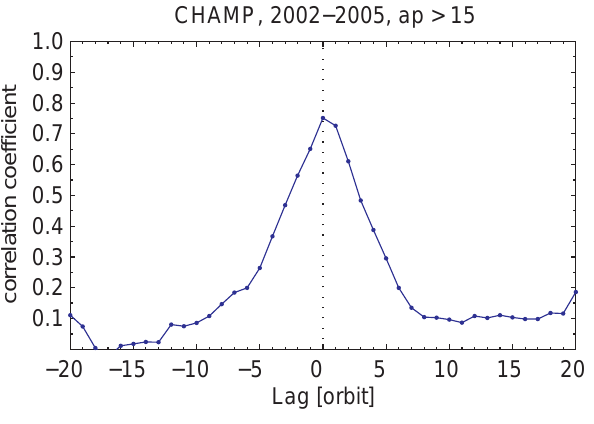
Fig. 10. Cross-correlation between the activity index a p and the density variations on the night side. Positive lags indicate a delayed response of the